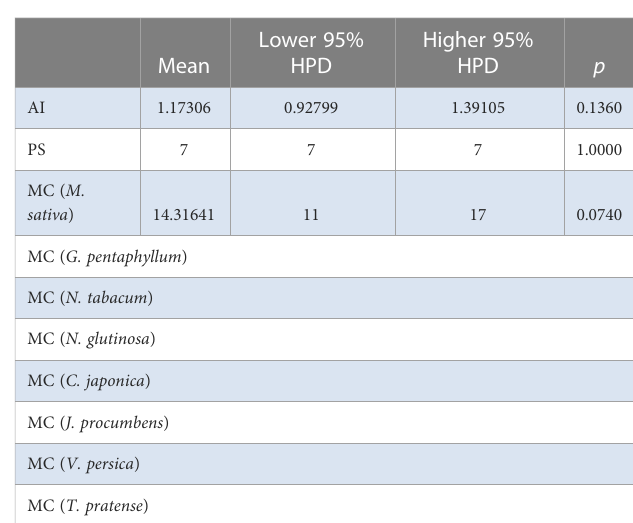
TABLE 4 BaTS algorithm analysis for for the Chinese AMV population based on host species